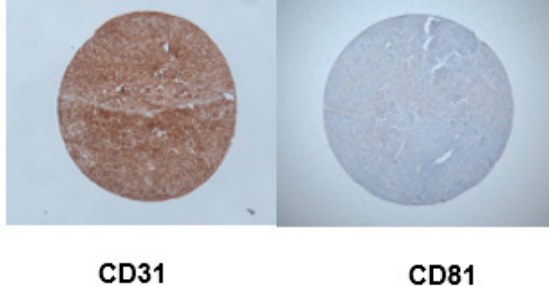
Figure 2. Expression of CXCR4, CD31, CD44 and CD81 by cPC. ( A ) Classical (medullary/osseous) MM vs. MM-EMD vs . pEMP/SOP. CD81 expression was not identified in any of 42 studied samples (not shown). ( B ) Classical MM vs . SOP or MM-EMD/pEMP paraskeletal vs. MM-EMD/pEMP not paraskeletal. Shown are percentages of samples with a moderate or strong expression intensity ( vs . negativity or low expression) from tested samples. ( C ) Representative immunohistochemistry study on tissue microarrays (TMA) showing strong CD31 expression of cPC (left, buccal MM-EMD) and lack of CD81 expression (right, MM-EMD with skin infiltration).